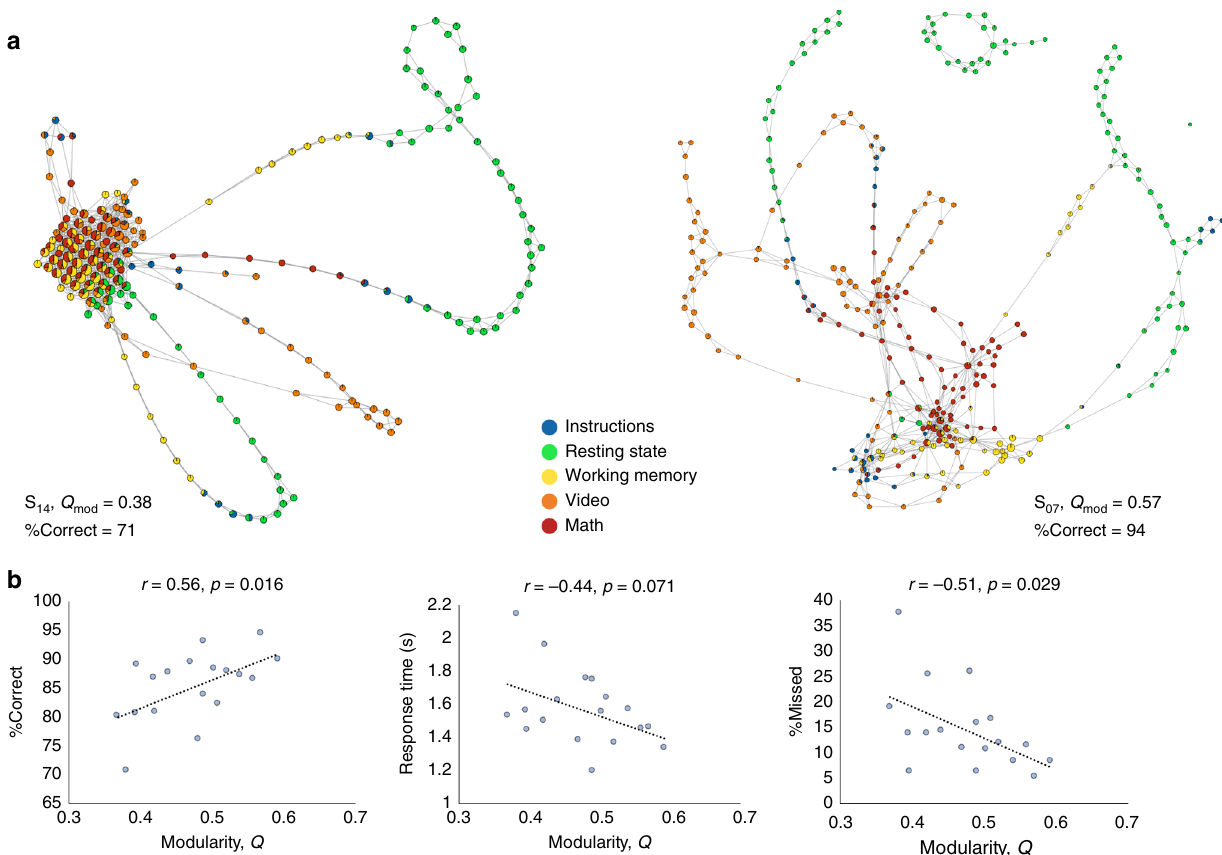
Fig. 3 Quantifying the mesoscale community structure of shape graphs. a Shows two shape graphs from two representative participants (S 14 and S 07 ). As depicted, S 14 had a low modularity score, i.e., nodes with different task types are connected to each other without any preference for same task nodes. On the other hand, shape graph from S 07 depicts high modularity structure with nodes preferentially connected to other nodes of same task type. b The modularity score ( Q mod ) was observed to be associated with task performance, such that higher modularity in the shape graph was associated with